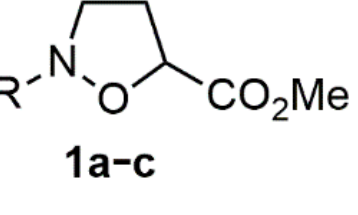
Figure 1. N -substituted isoxazolidines.